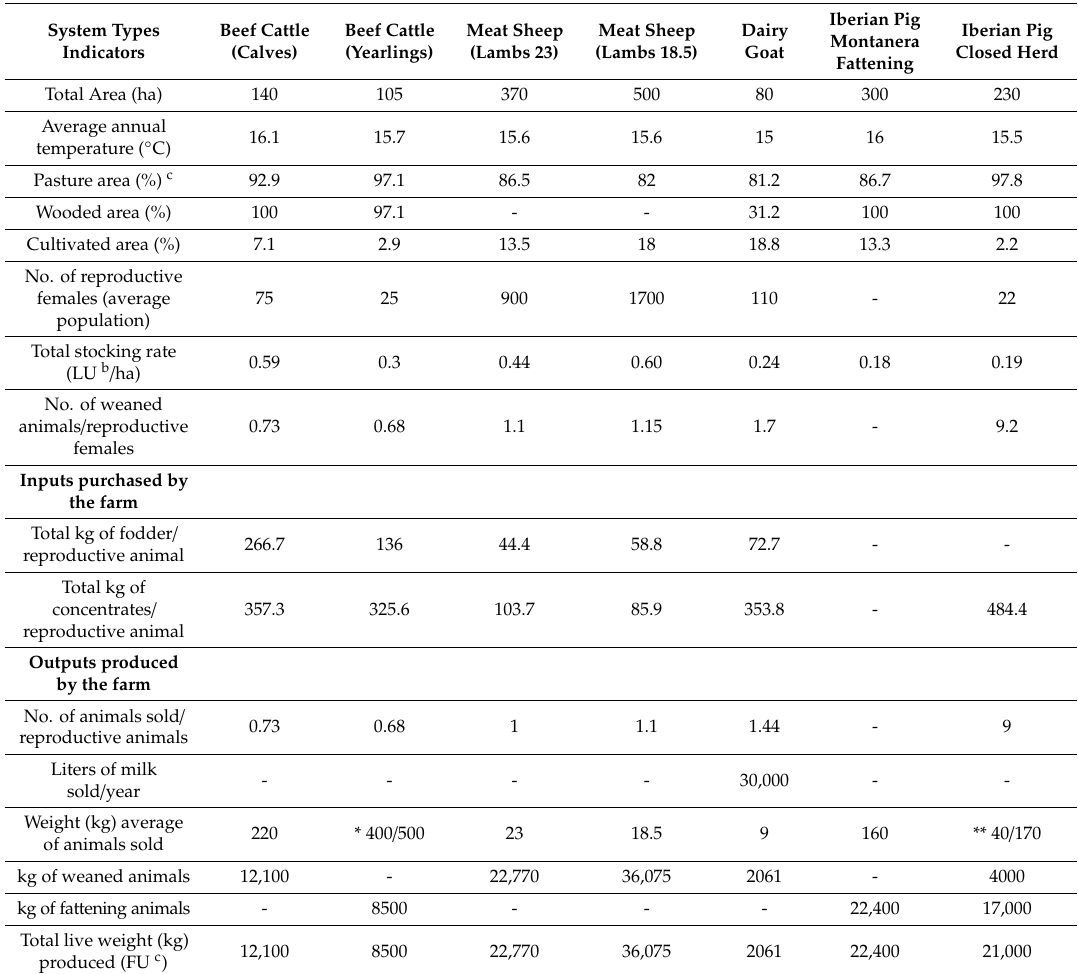
Table 3. Technical indicators of the farms included in this